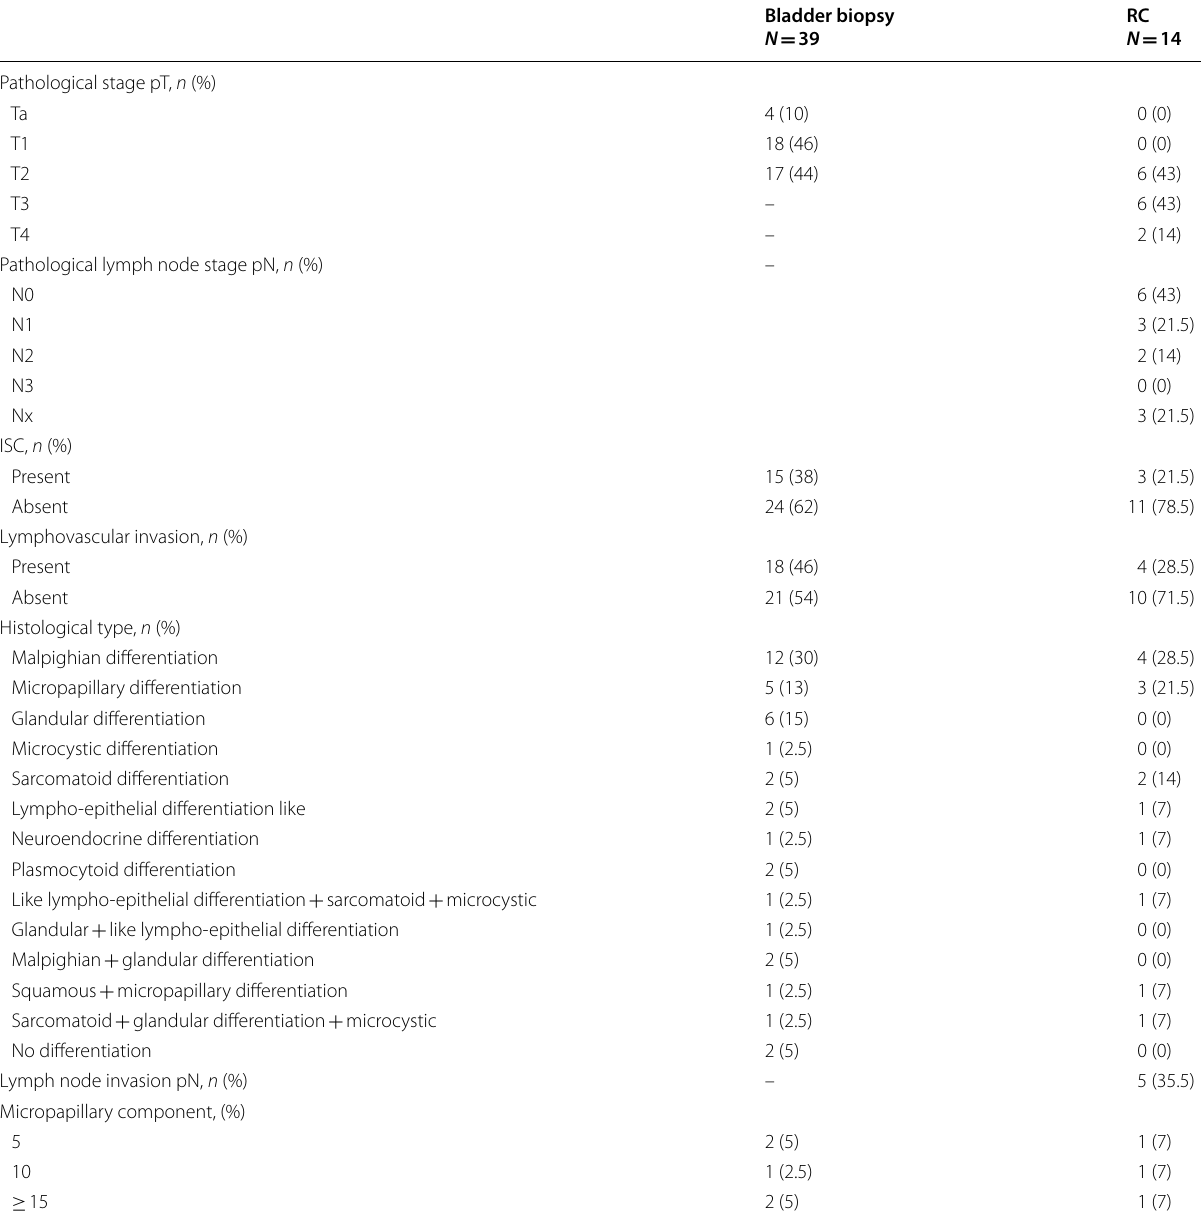
Table 2 The pathological characteristics of the bladder biopsy and the operating room of the patients in our